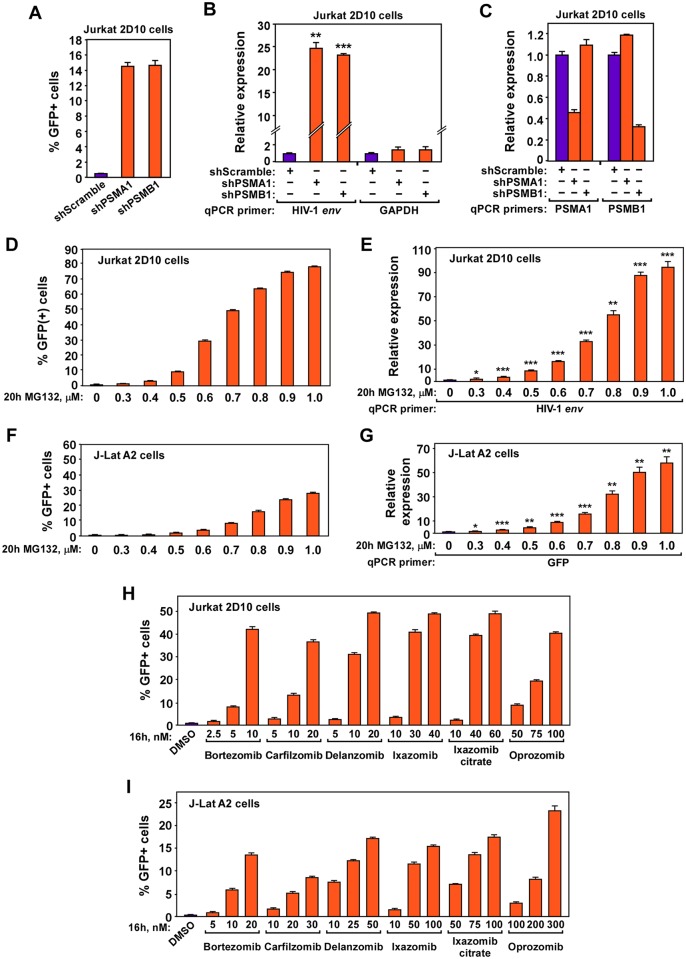
Downregulating proteasomal core subunits or inhibiting proteasomal activity promotes HIV-1 transcription and latency reversal in cell line models.A., B., & C. Jurkat 2D10 cells were nucleofected with the indicated siRNAs. Aliquots of the cells were subjected to FACS analysis to detect the percentages of GFP+ cells in each population (A) or RT-qPCR analysis of the mRNA levels produced by the genes labeled at the bottom (B & C). D., E., F., G., H., & I. Jurkat 2D10 (D, E, & H) or J-Lat A2 cells (F, G, & I) were treated with the indicated proteasome inhibitors at the indicated concentrations for either 16 or 20 hours as labeled. The treated cells were then subjected to FACS analysis to determine the percentages of GFP+ cells in each population (D, F, H, & I) or RT-qPCR analysis to examine the mRNA levels from the genes denoted by their specific qPCR primer (E & G). In all panels, error bars represent mean +/- SD from three experimental replicates. In B, E, & G, asterisks denote levels of statistical significance calculated by two-tailed Student’s t-test (*: p<0.05, **: p<0.01, and ***: p<0.001).